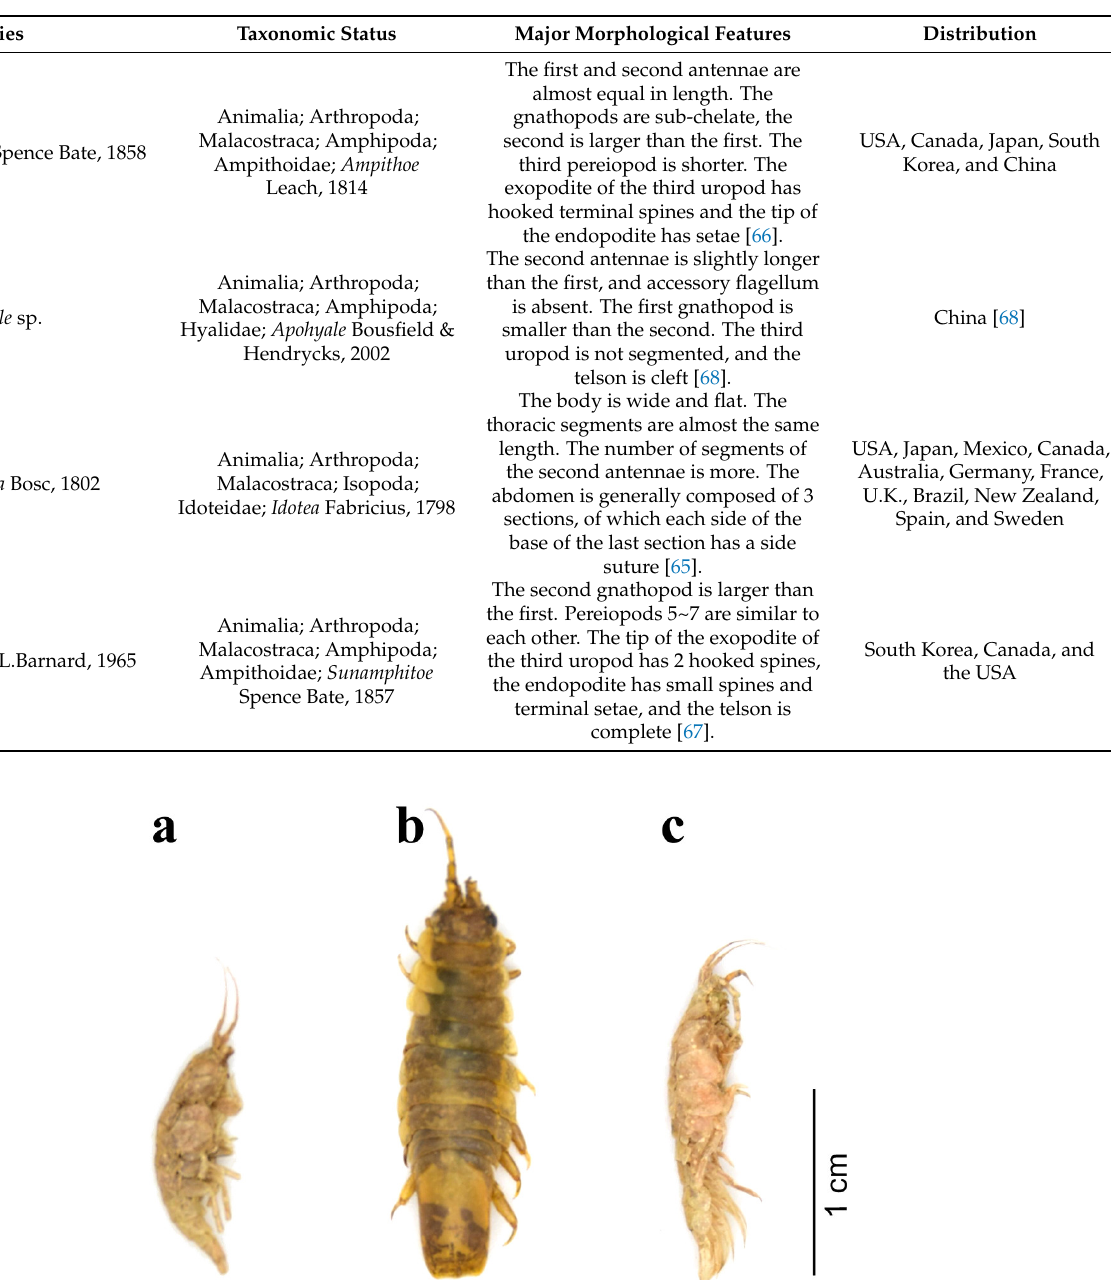
Table 3. Taxonomy, major morphological features, and distribution of epizoans.